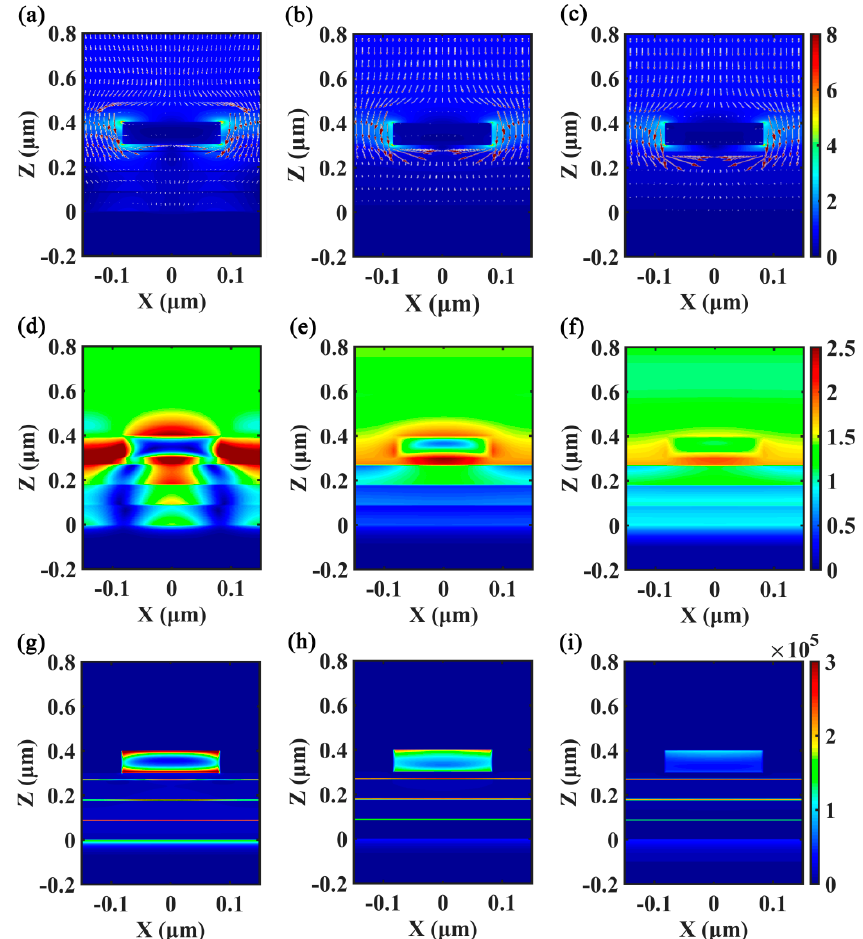
Figure 3. Distributions of electromagnetic field, Poynting vector, and current density associated with the absorption peaks of the Cr-based MA. Other parameters are the same as Figure 1a. ( a – c ) are the near field distributions of | E | and Poynting vector at 451.2 nm, 884.5 nm, and 1642.3 nm, respectively. The red arrow indicates the direction of Poynting vector. ( d – f ) are the near field distributions of | H | at 451.2 nm, 884.5 nm, and 1642.3 nm, respectively. ( g – i ) are the distributions of current density at 451.2 nm, 884.5 nm, and 1642.3 nm, respectively.